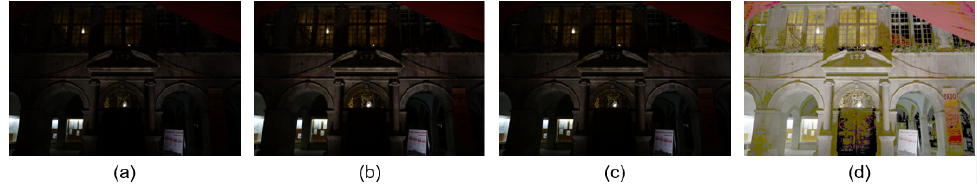
Figure 9. Limitation of OAGC. ( a , b ) Input images. ( c ) Virtual image I v using [9]; ( d ) virtual image processed using OAGC I γ